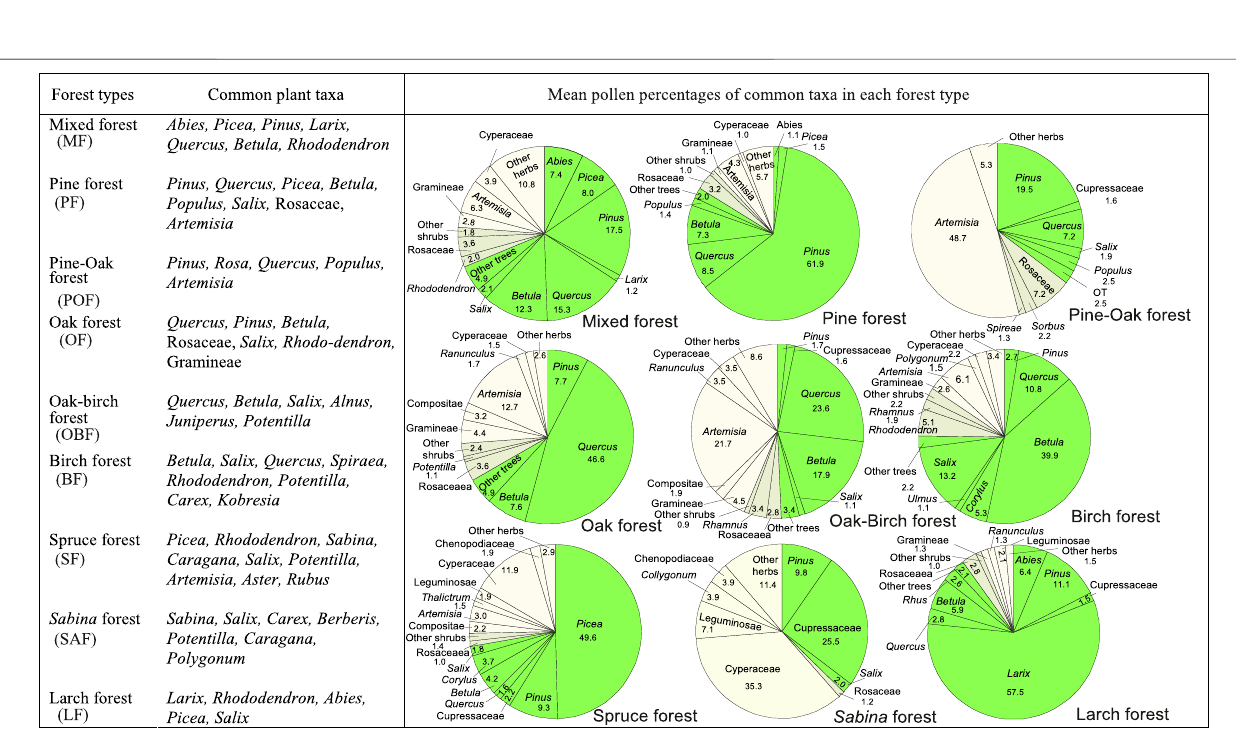
FIGURE10| ForesttypesintheTPandtheircommonplanttaxaandrepresentativepollenassemblages.Piegraphsintherightshowthemeanpercentagesofthe common pollen taxa, calculated by averaging the pollen percentages of the corresponding taxa within each group. For forest type classi fi cation, see Figure 3 .